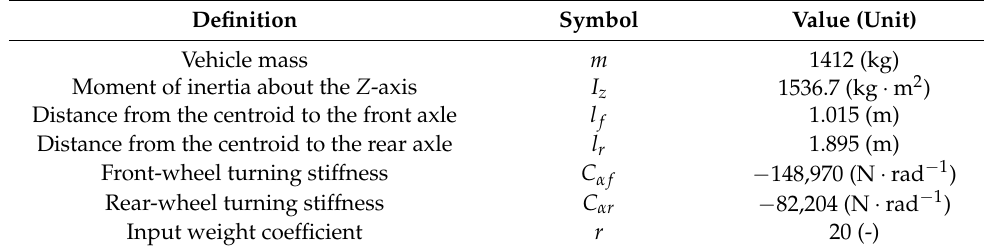
Figure 23. The improved LQR controller model running under the Simulink–Carsim simula- tion platform. Table 3. Parameters for